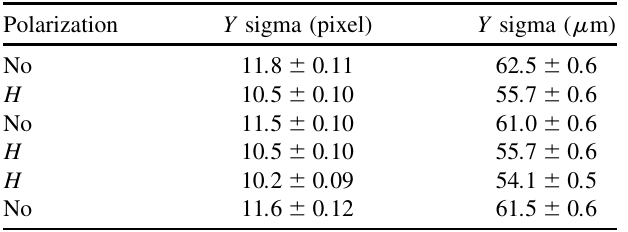
TABLE III. Summary of horizontal-stripe data. The horizontal ( H ) polarization data are indicated in determining the y sizes. The calibration factor is 5 : 3 (cid:1) m per